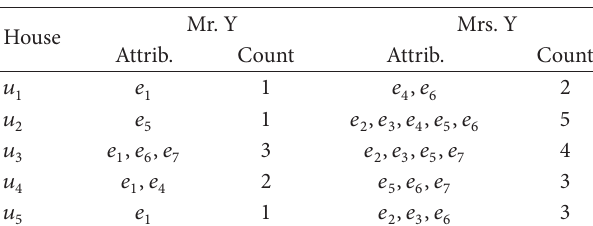
Mr. Y Mrs. Y House Attrib.